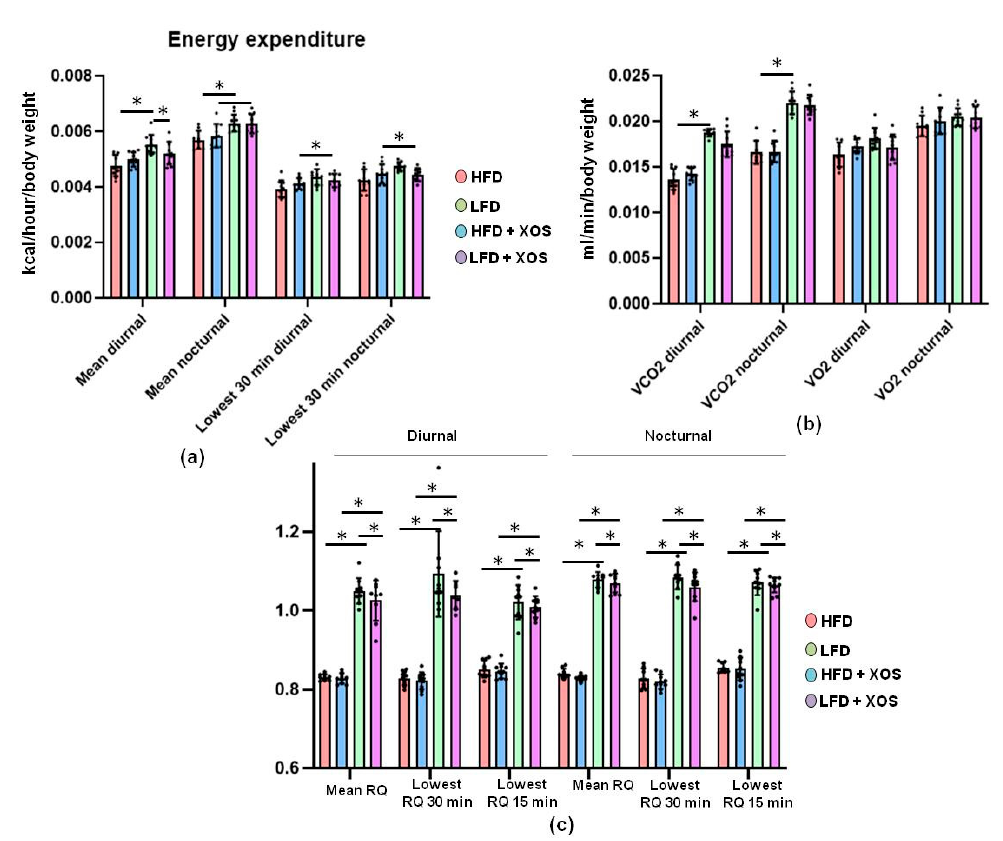
Figure 11. The LFD increased the energy expenditure in rats, while XOS and diet had an interactive effect on the respiratory quotient. ( a ) The average hourly energy expenditure was highest at nighttime in the LFD and the lowest measured energy expenditure was highest in the LFD at daytime. The values are presented divided by body weight in grams; ( b ) The HFD diminished the production of CO 2 at daytime, whereas in O 2 consumption, no differences between the groups were found. The values are presented divided by body weight in grams; ( c ) The respiratory quotient (RQ) values were calculated as VCO 2 /VO 2 . The different data points are shown with black dots. * indicates statistically significant difference between the groups.